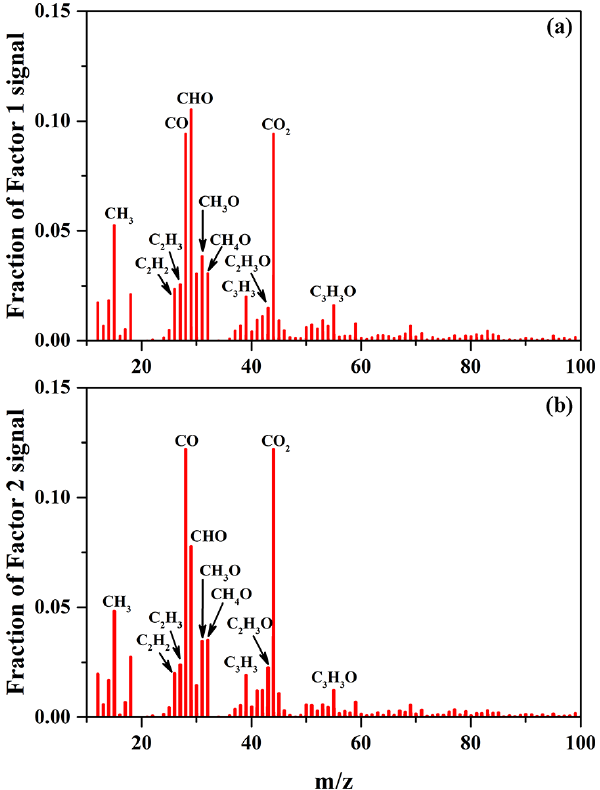
Figure 4. Mass spectra of Factor 1 (a) and Factor 2 (b) for the formed SOA identified by applying PMF analysis to the AMS data, obtained at different SO 2 concentrations over the course of the ex- periments.